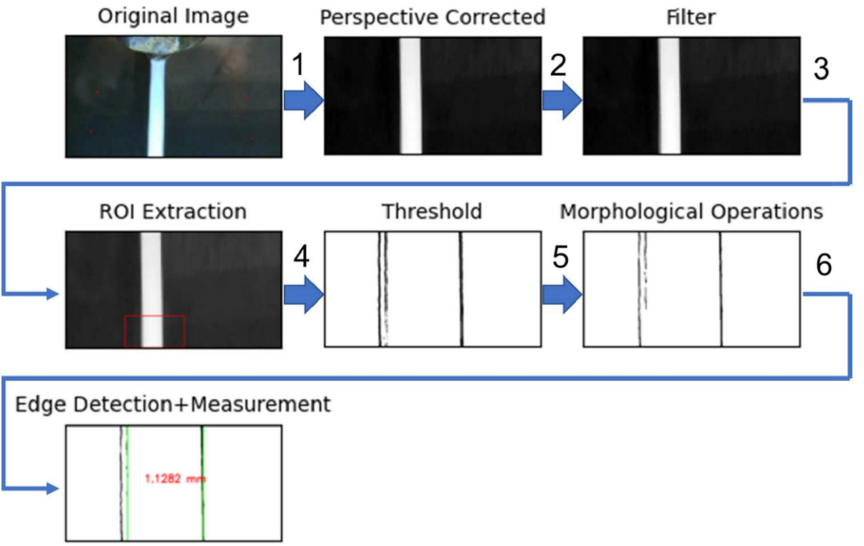
Figure 8. Sequence of image processing steps used and corresponding algorithms-(1) four-point perspective correction, (2) Bilateral Filtering, (3) Image re-sizing, (4) Adaptive Gaussian Thresholding, (5) Multi-pass morphological closing, (6) REXR algorithm.